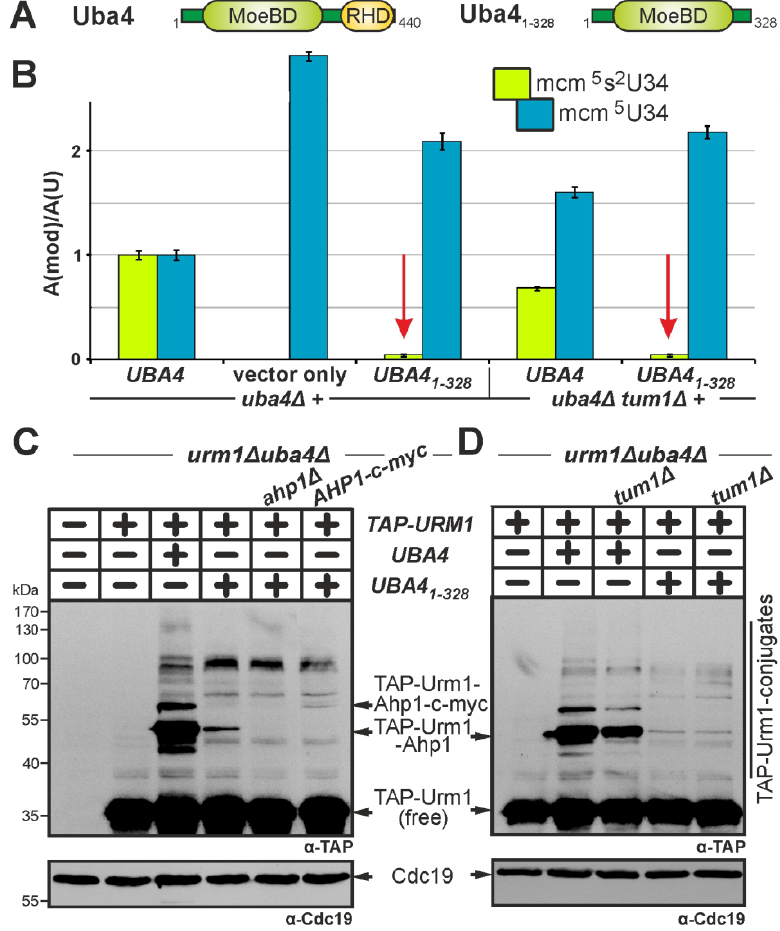
FIGURE 5: Low residual tRNA thiolation and urmylation without the RHD on Uba4 is inde- pendent of sulfur transfer by Tum1. (A) Scheme depicting Uba4 1-328 , which lacks the RHD